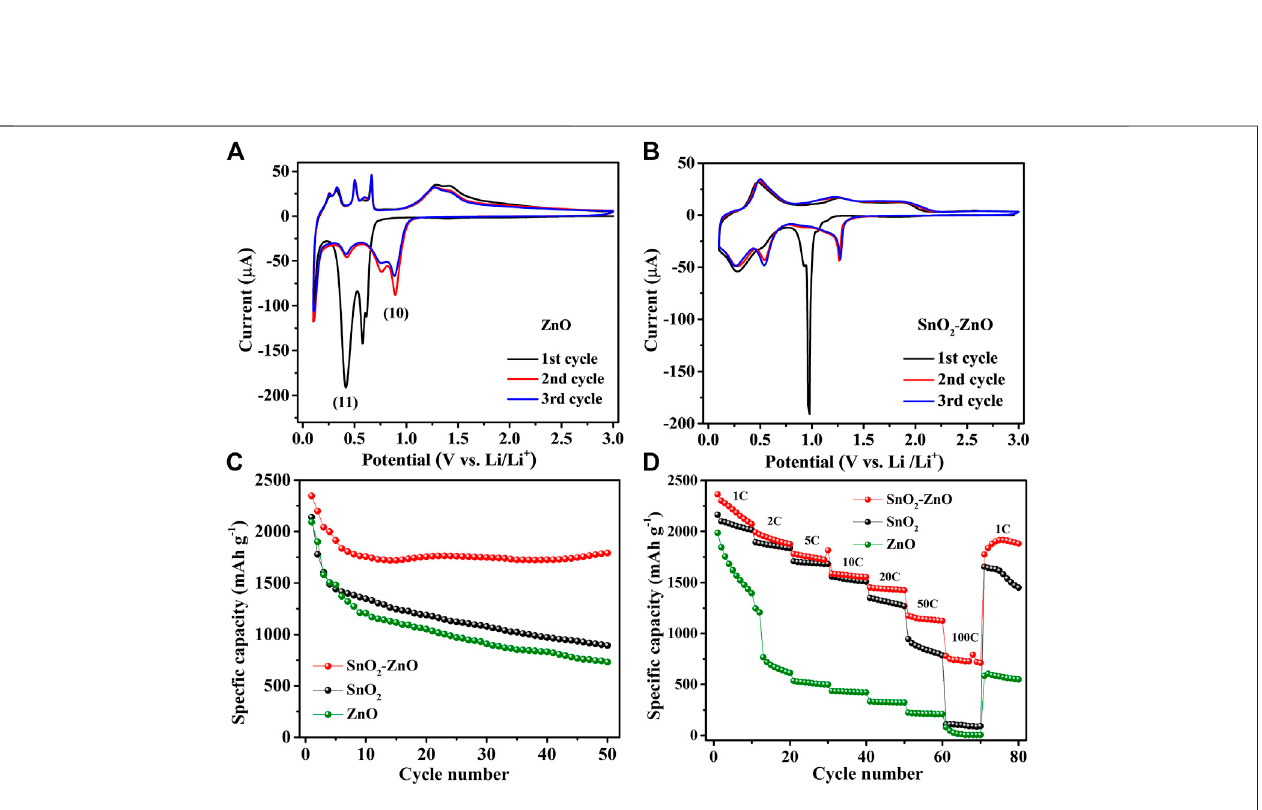
Frontiers in Energy Research |